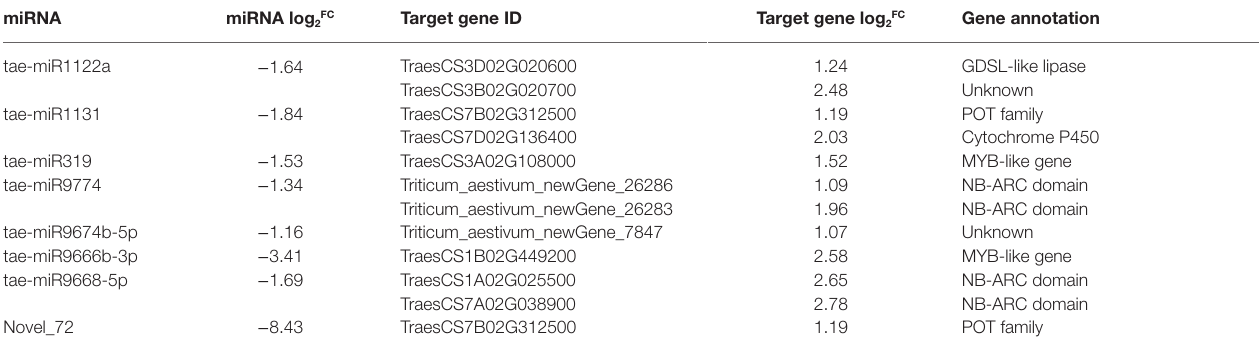
TABLE 3 | Salt tolerance related miRNAs and their target genes in QM6. miRNA